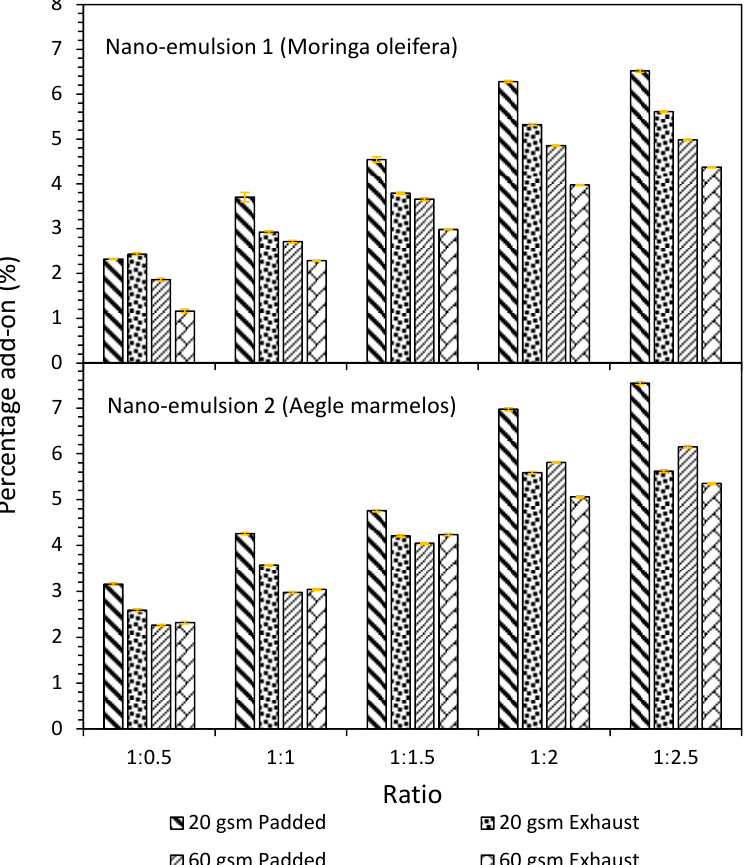
Figure 6. Percentage add-on of nano-emulsions.